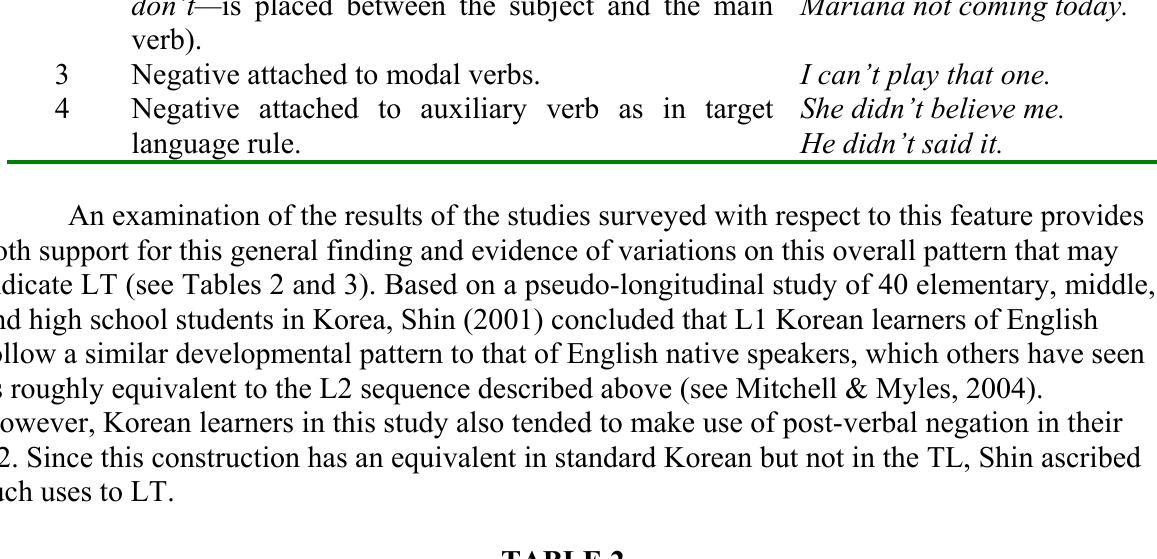
English L2 Negation in Group A